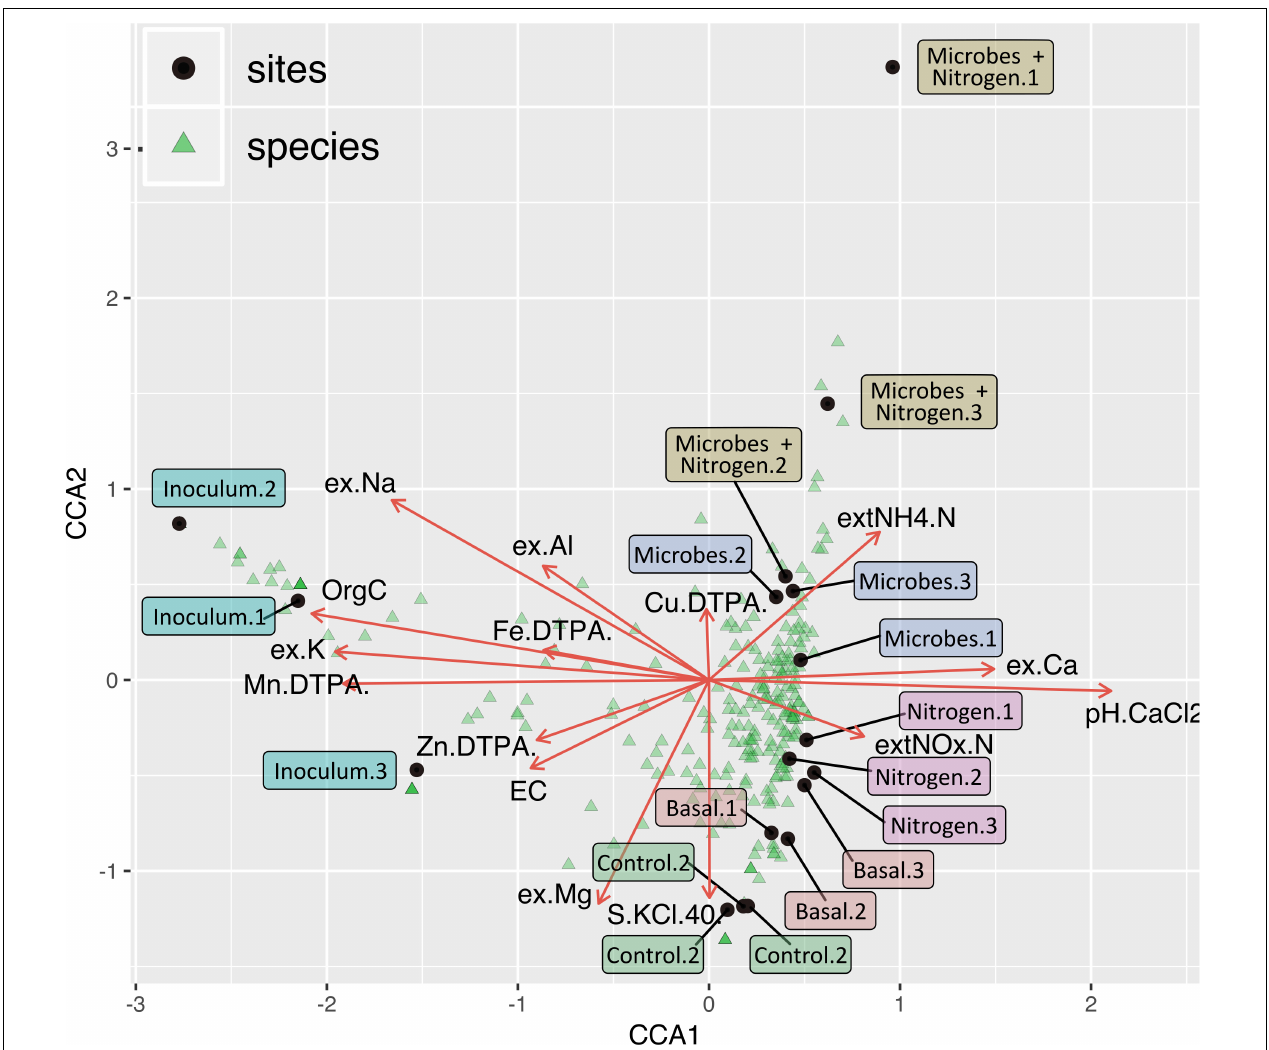
FIGURE 6 | Correspondence analysis tri-plot showing soils samples (orange), taxonomic bins (at an order level, light blue), and soil chemistry parameters (brown arrow). While some orders are specific to certain treatments, a major part of the identified genera within the dataset are been shared by treatments control, basal, nitrogen, and